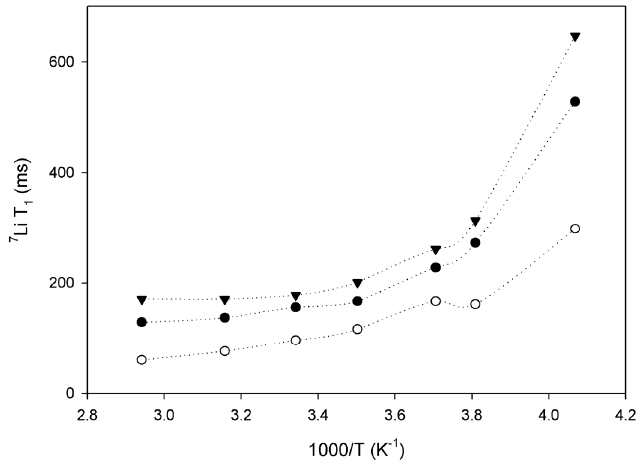
Figure 4. 7 Li longitudinal relaxation (T 1 ) as a function of inverse temperature for sample 1 (black triangles), sample 2 (open circles) and sample 3 (black circles).